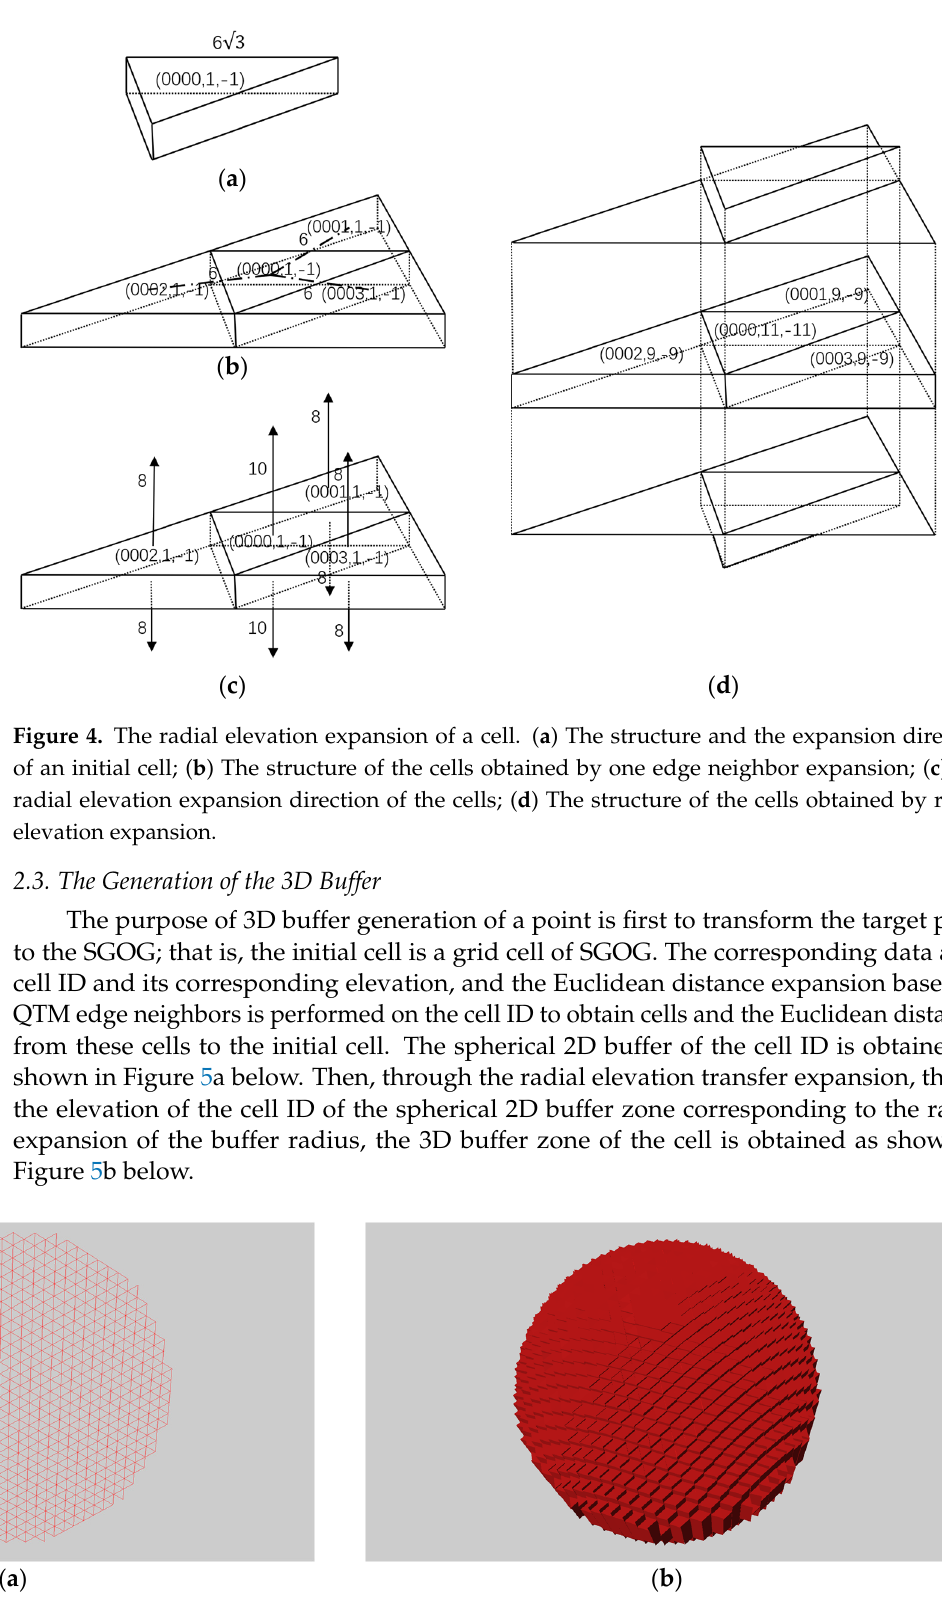
triangular mesh discrete line by Zhao et al. [34] was used to discretize the spherical trian- gular mesh of a vector line. Then, the cells of the entire line in the SGOG were expanded in a 3D buffer, and the cell IDs and upper and lower elevation data of the buffer were obtained. Different initial cells may produce cells with repeated cell IDs when the 3D buffer is expanded, and because the corresponding initial cells of the repeated cells are different, the upper and lower elevation data of the repeated cells will be different. There- fore, it is necessary to obtain the union of the obtained buffer cells and perform data fusion on the repeated cells. For the cells with repeated cell IDs in all the obtained buffer cells, only one cell corresponding to the cell ID was retained. The upper elevation of this re- tained cell ID is the maximum value of the elevation subset on the repeated cell, and the lower elevation of it is the minimum value of the elevation subset on the repeated cell. In summary, 3D buffer generation of the line was completed, and the effect diagram is shown in Figure 6. Figure 6. The 3D buffer of a line. Cells marked as the target line are shown in blue, and cells marked as the buffer are shown in red. With regard to the 3D buffer generation algorithm for area objects and volume ob- jects, in view of the similarity between an area object and a volume object when they are transformed to the SGOG, the area object is a volume object with a very small difference between the upper and lower elevations, and the generated 3D buffers are also volume objects. Therefore, the 3D buffer generation algorithms for the two are the same. First, the